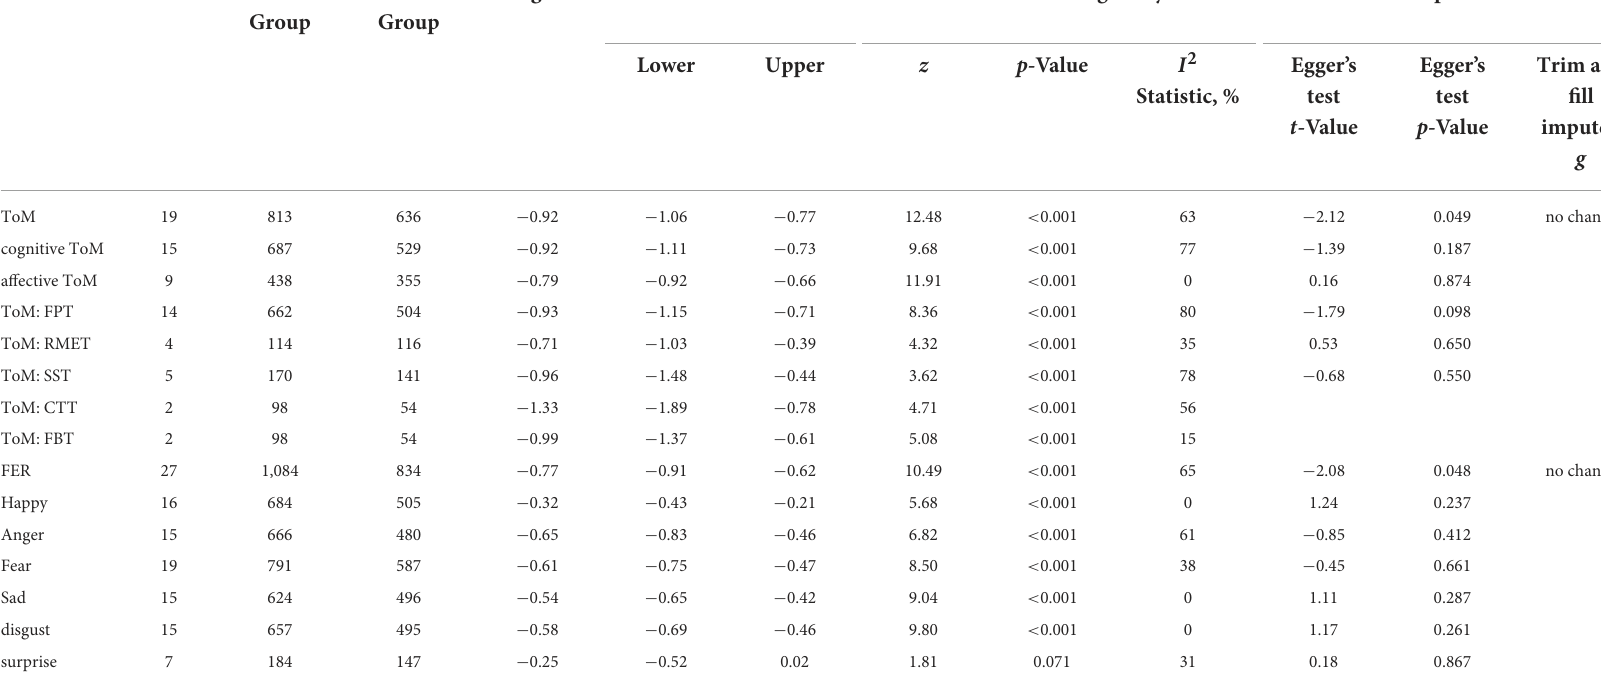
TABLE 3 Mean effects for ToM and FER subcomponents comparing adult with TLE against healthy controls and tests for publication